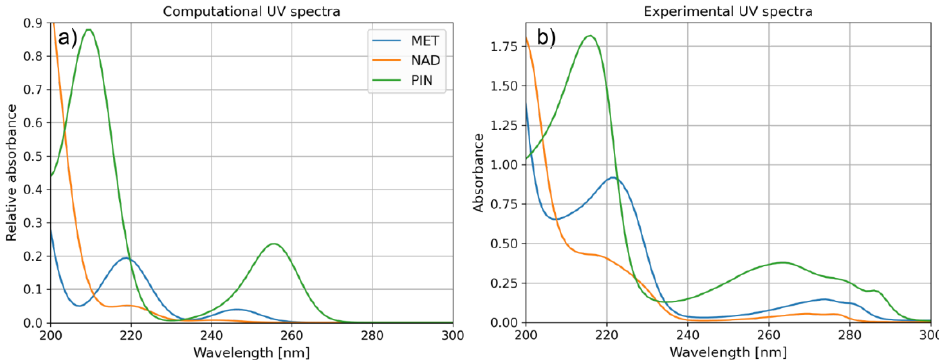
Figure 8. ( a ) Computational and ( b ) experimental UV spectra of MET, NAD, and PIN.